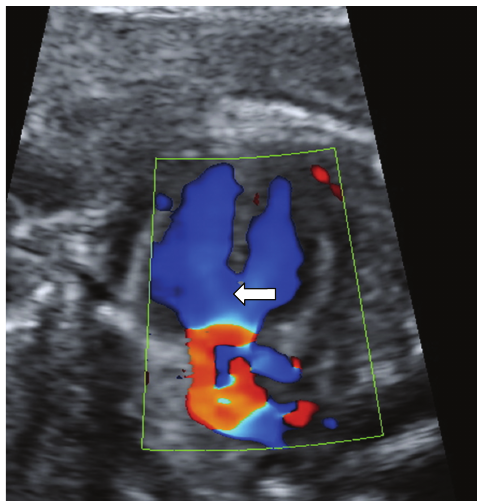
Figure 3: Transabdominal ultrasound showing a dysplastic (multi- cystic) kidney (arrow).